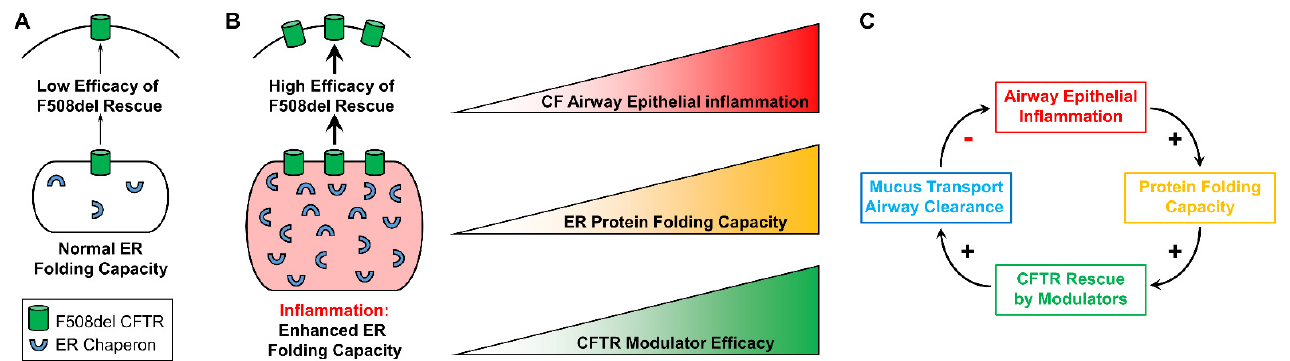
Figure 3. Proposed model for the interplay between airway epithelial inflammation and CFTR rescue. ( A ): In the absence of airway epithelial inflammation, the ER protein folding capacity is normal and associated with a lower efficacy of F508del recue. ( B ): Inflammation expands the ER and enhances its protein folding capacity, which should facilitate F508del CFTR rescue. We propose a linear correlation between airway epithelial inflammation, ER protein folding capacity, and efficacy of CFTR modulators in vitro. Modified from Gentzsch et al., 2021 [32]. ( C ): Proposed in vivo relationship between CF airway epithelial inflammation, ER protein folding capacity, CFTR rescue, and airway mucociliary clearance. Modified from Gentzsch et al., 2021 [32].